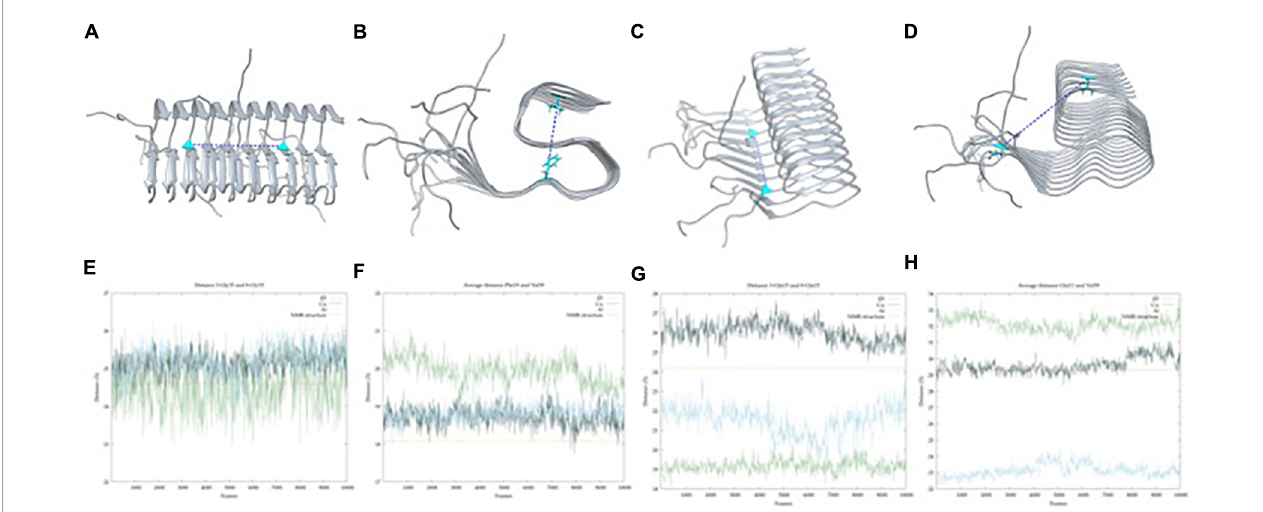
FIGURE6 Atoms chosen for the horizontal distance (A) , vertical distance (B) , 11–15 β -strand intersheet distance (C) and opening of the 1–18 region (D) represented in the solid-state NMR (ss-NMR) model. Results of the horizontal (E) , with an average distance of 24.6 ( ± 5.6)Å, 25.2 ( ± 1.6)Å and 25.5 ( ± 10.9)Å for metal-free, Cu(II) and Al(III) systems; vertical (F) , with an average distance of 19.9 ( ± 0.3)Å, 18.7 ( ± 0.2)Å and 18.8 ( ± 0.2)Å for metal-free, Cu(II) and Al(III) systems; intersheet (G) ; with an average distance of 19.3 ( ± 5.2)Å, 26.06 ( ± 1.1)Å and 21.5 ( ± 0.7)Å for metal-free, Cu(II) and Al(III) systems; and opening (H) , with an average distance of 32.1 ( ± 0.4)Å, 29.6 ( ± 0.5)Å and 23.1 ( ± 0.4)Å for metal-free, Cu(II) and Al(III) systems; along the MD simulation, with ss-NMR distance represented in yellow